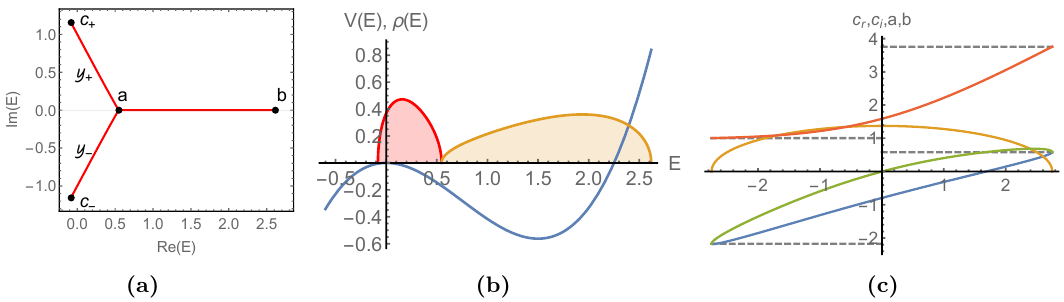
Figure 23. (a) The “Y” shaped solution D ρ on the complex E plane for t = 3 / 2 . Note that Y ± are not exactly straight lines. (b) The potential V ( E ) (blue) and “Y” shaped spectral density (shaded yellow and red) for t = 3 / 2 . The potential well on the real axis is not deep enough to hold all of the eigenvalues in a real cut. The shaded red region is the plot of the spectral density on Y + projected to the real axis as a function of E (see (C.20)). (c) The plot of c r (blue), c i (yellow), a (green) and b (red) as functions of t ∈ ( − t cr , t cr ) . The gray dashed lines mark the values that match with